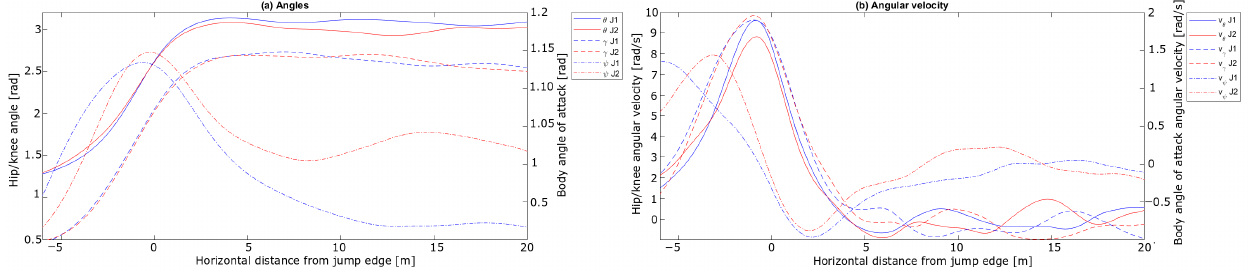
Figure 12. Knee angle ( θ ), hip angle ( γ ) and body angle of attack ( ψ ) measured during the take-off phase for the jumps in the case analysis. ( a ) shows the angles and ( b ) the respective angular velocity. The horizontal length from the in-run edge is shown on the x-axis, angles in rad on the vertical axis in ( a ) and angular velocity in rads − 1 in ( b ).